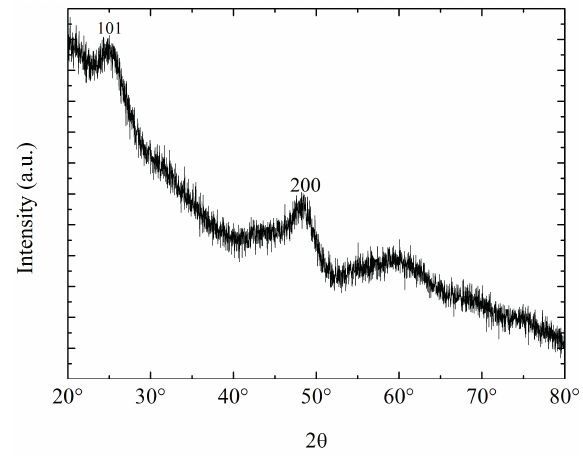
heat-treated at 250 °C. 2